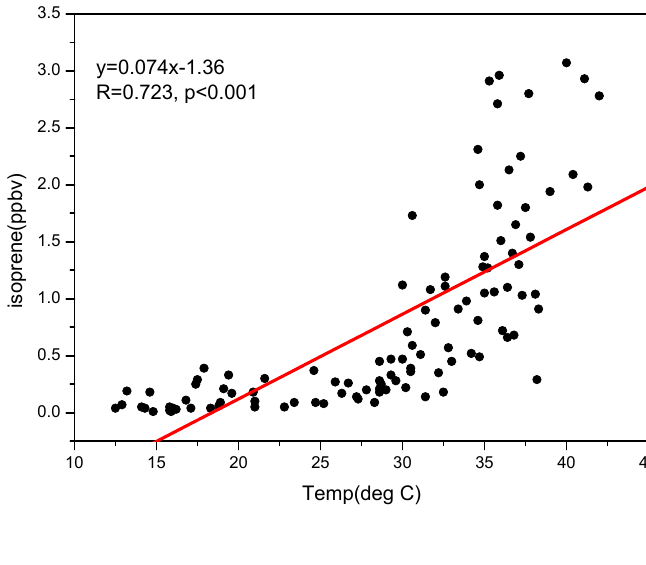
Figure 4. Scatter plots for isoprene versus temperature in